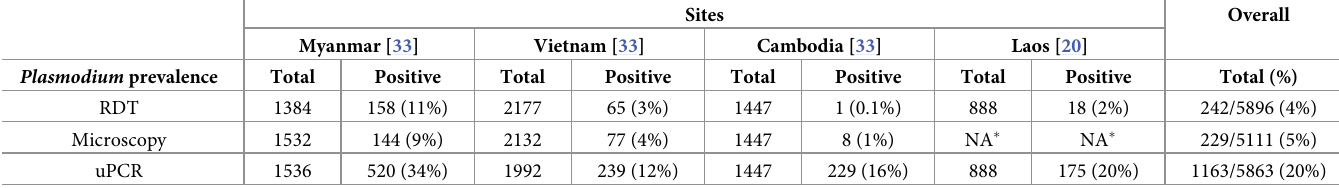
Table 1. Malaria prevalence at TME sites based on surveys prior to MDA (all